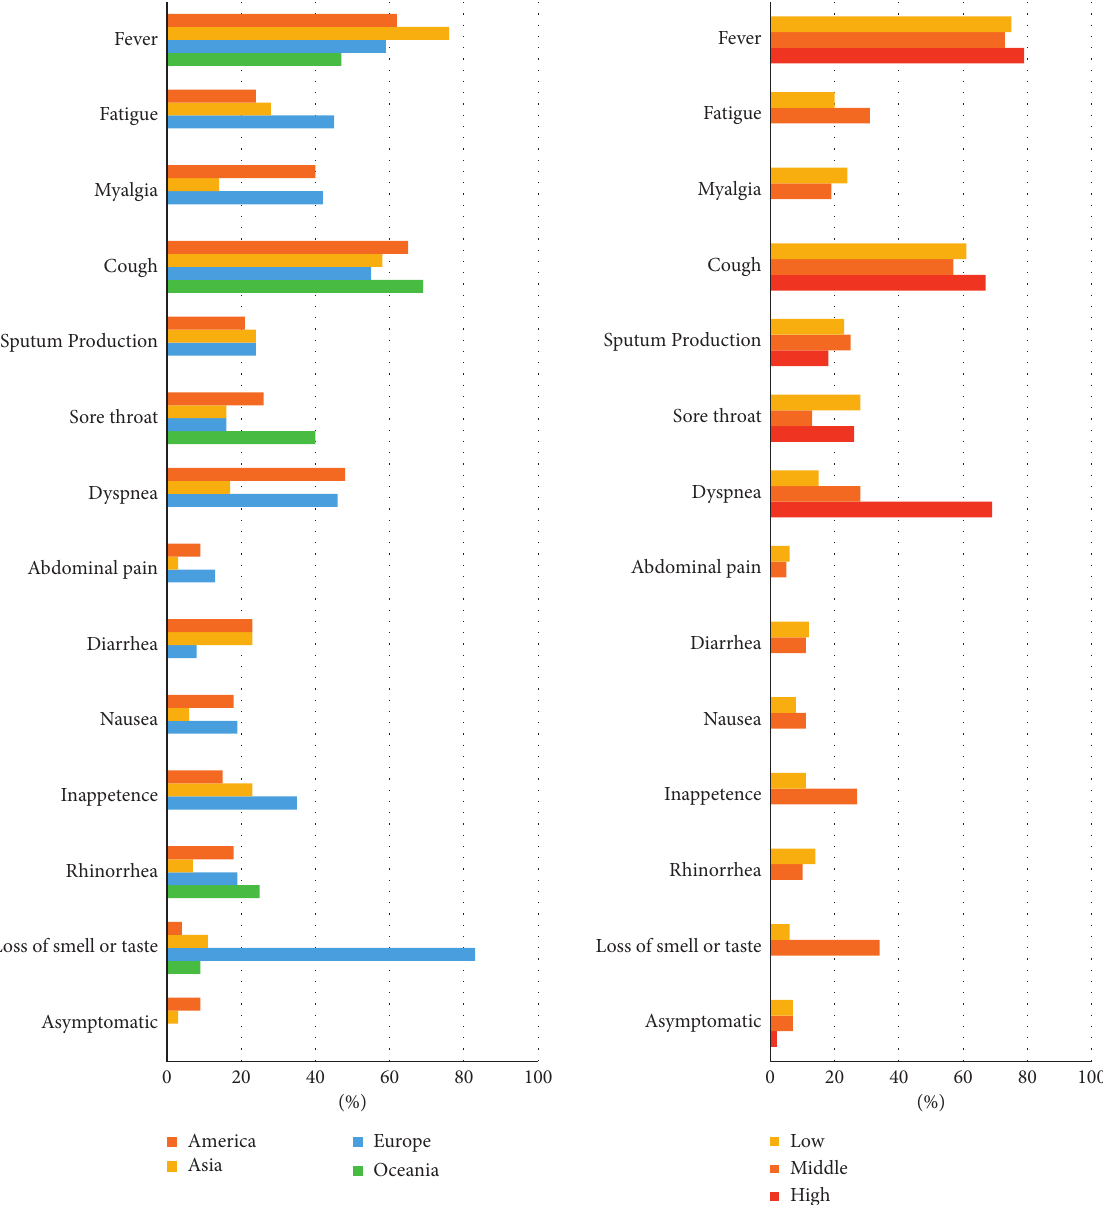
Figure 4: Clinical manifestations of COVID-19 patients in different